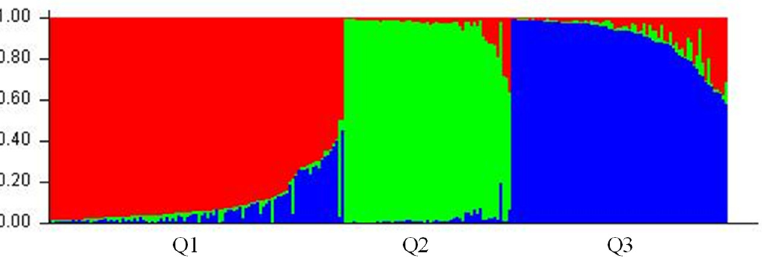
Figure 3. Phylogenetic tree of the accession with three different colors indicating three groups obtained from the STRUCTURE analysis result. Red, green and blue represent Q1, Q2 and Q3 respectively. The vertical coordinate of each subgroup indicates the membership coefficients for each C. hystrix accession.